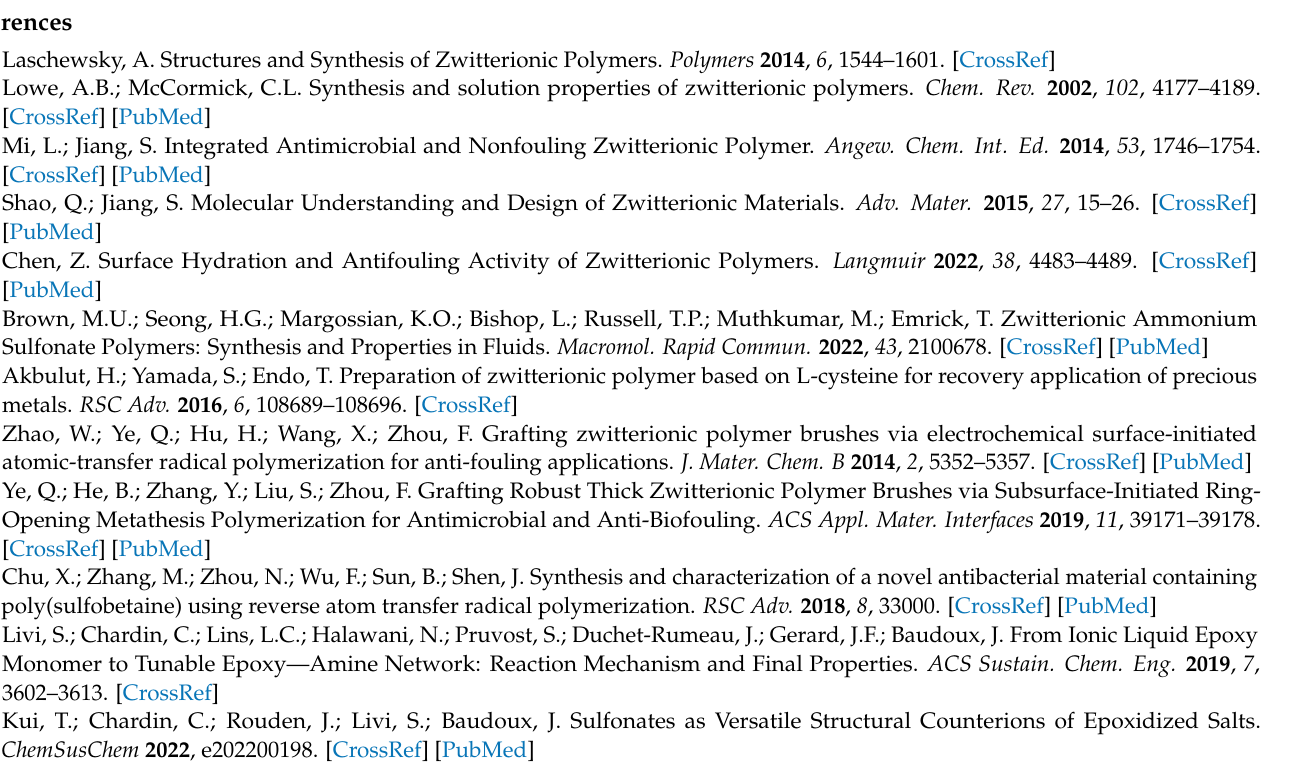
Supplementary Materials: Figure S1: 1 H NMR spectrum of monomer 2 recorded in D 2 O, Figure S2: 13 C NMR spectrum of monomer 2 recorded in D 1 H NMR spectrum of monomer 4 2 O, Figure S3: recorded in D 2 O, Figure S4: 13 C NMR spectrum of monomer 4 recorded in D 2 O, Figure S5: FTIR spectrum of monomer 2 , Figure S6: FTIR spectrum of monomer 4 , Figure S7: Thermogravimetric analysis (TGA) and derivative thermogravimetric curves of monomer 2